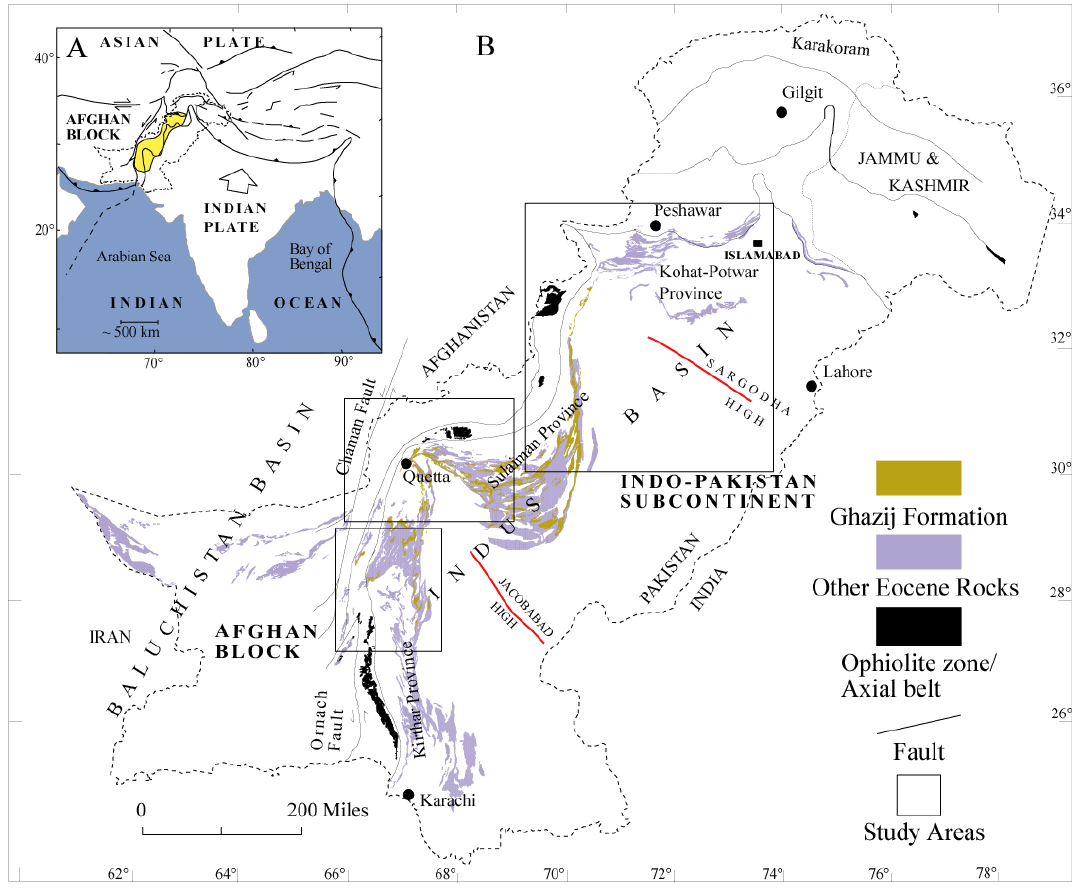
Figure 1. ( A ) Inset map showing regional tectonic setting, faults and suture zone between the Indo-Pakistan subcontinent and the Asian continent. The yellow color represents the study area; ( B ) Map showing the Eocene rock deposits (Ghazij Formation is golden color), major faults, and the ophiolite zone/axial belt of Pakistan. The rock exposure follows the structural trend of the axial belt and is restricted to the western margin of the Indian